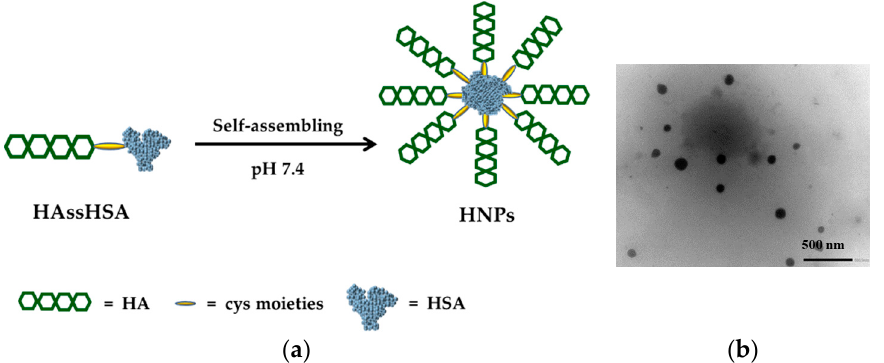
Figure 4. ( a ) Proposed architecture of the vesicle membrane and ( b ) TEM image of negatively stained HNPs (20 K magnification).